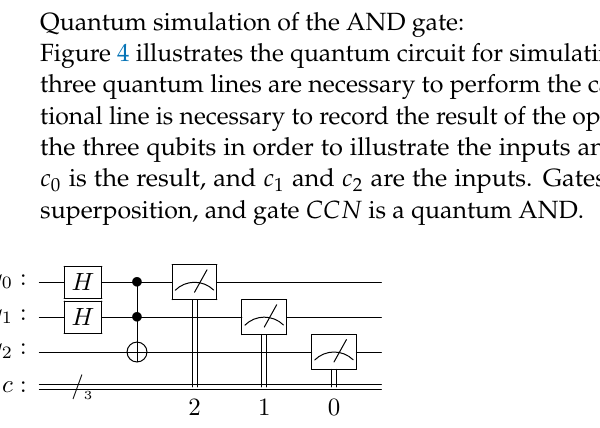
Figure 3. Results for the NOT operation.